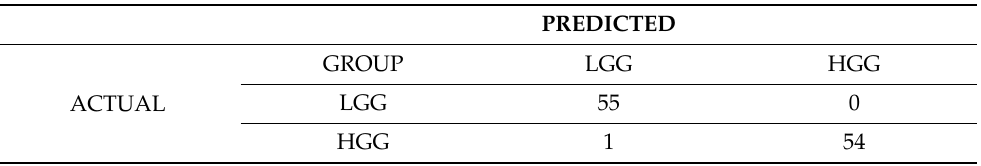
Table 4. Evaluation metrics ’ precision, recall, specificity, and sensitivity for the DNN model where the connectivity matrix was used as a matrix is shown (values are given up to four decimal places to track even slight differences in the model ’ s performance).